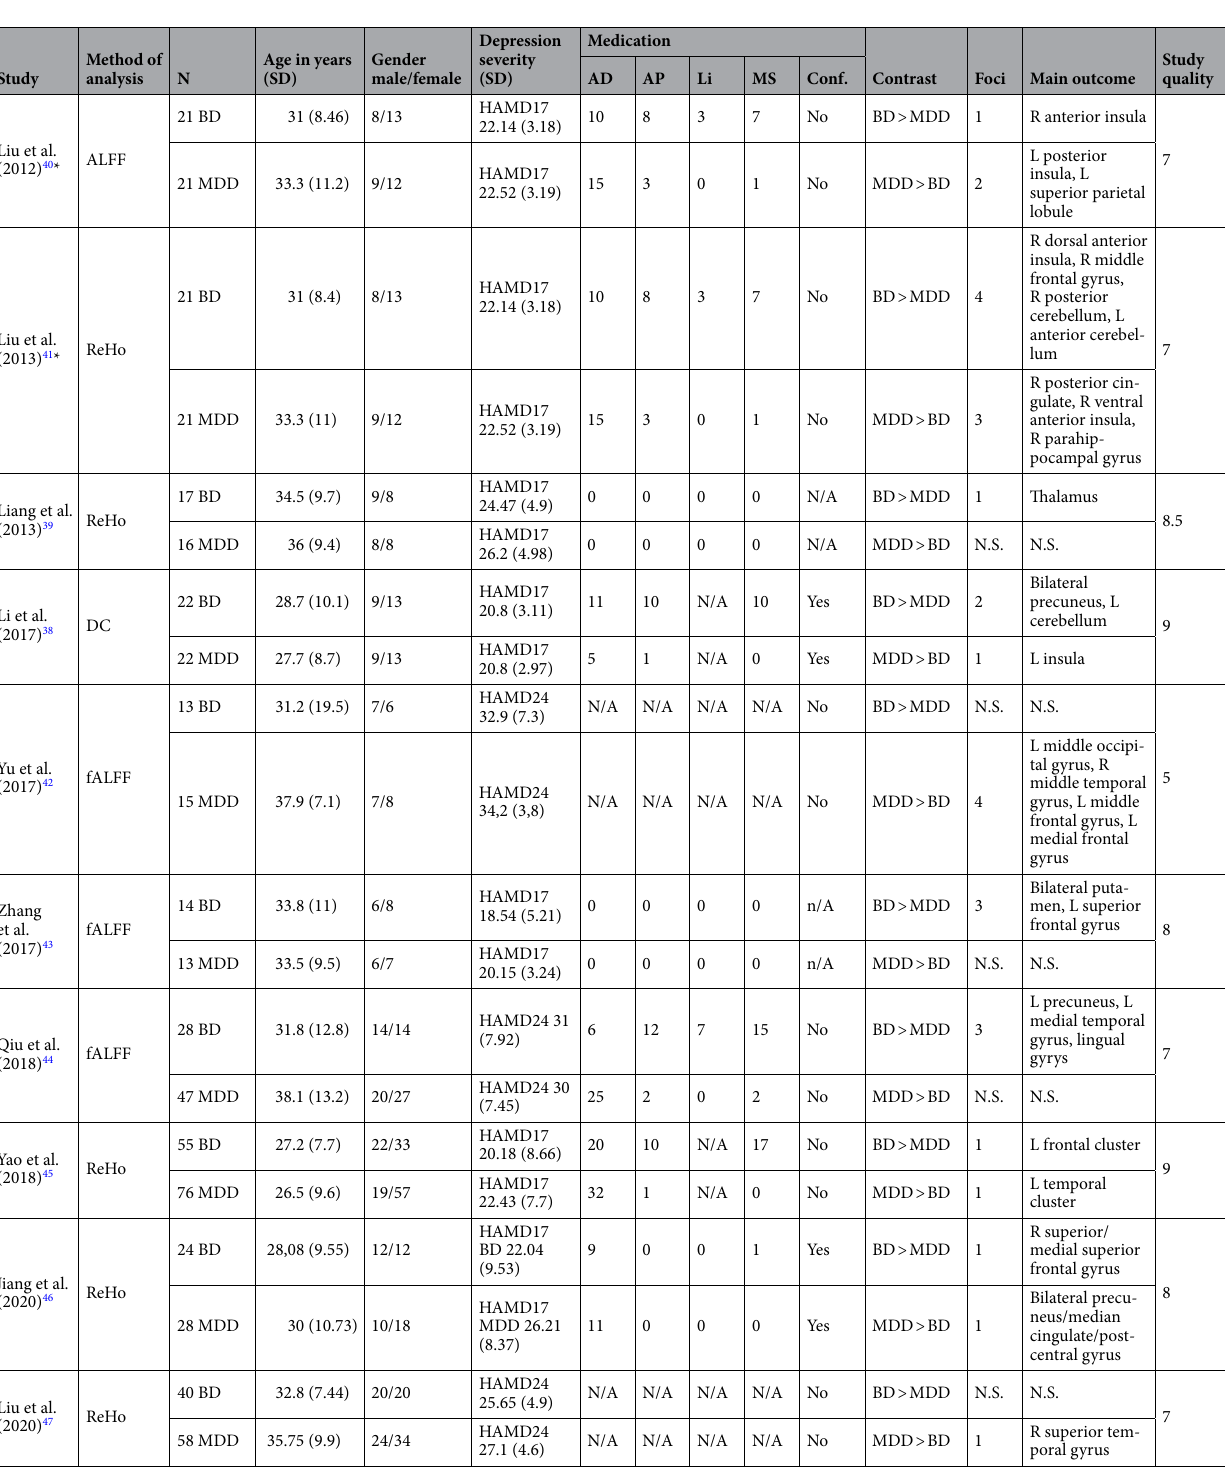
Table 1. Studies included in the meta-analysis, methods of analysis, demographics, clinical data, medication, between-group contrasts, number of foci, main study outcome and study quality. AD antidepressant, ALFF amplitude of low frequency fluctuations, AP antipsychotics, BD bipolar disorder, Conf. whether medication was used as a confound, DC degree centrality, fALFF fractional ALFF, HAMD Hamilton Depression Rating Scale—17 items or 24 items, Li lithium, MDD major depressive disorder, MS mood stabilizer other than lithium, N number of subjects, N/A information not available, N.S. no significant group differences, ReHo regional homogeneity, SD standard deviation. *Same